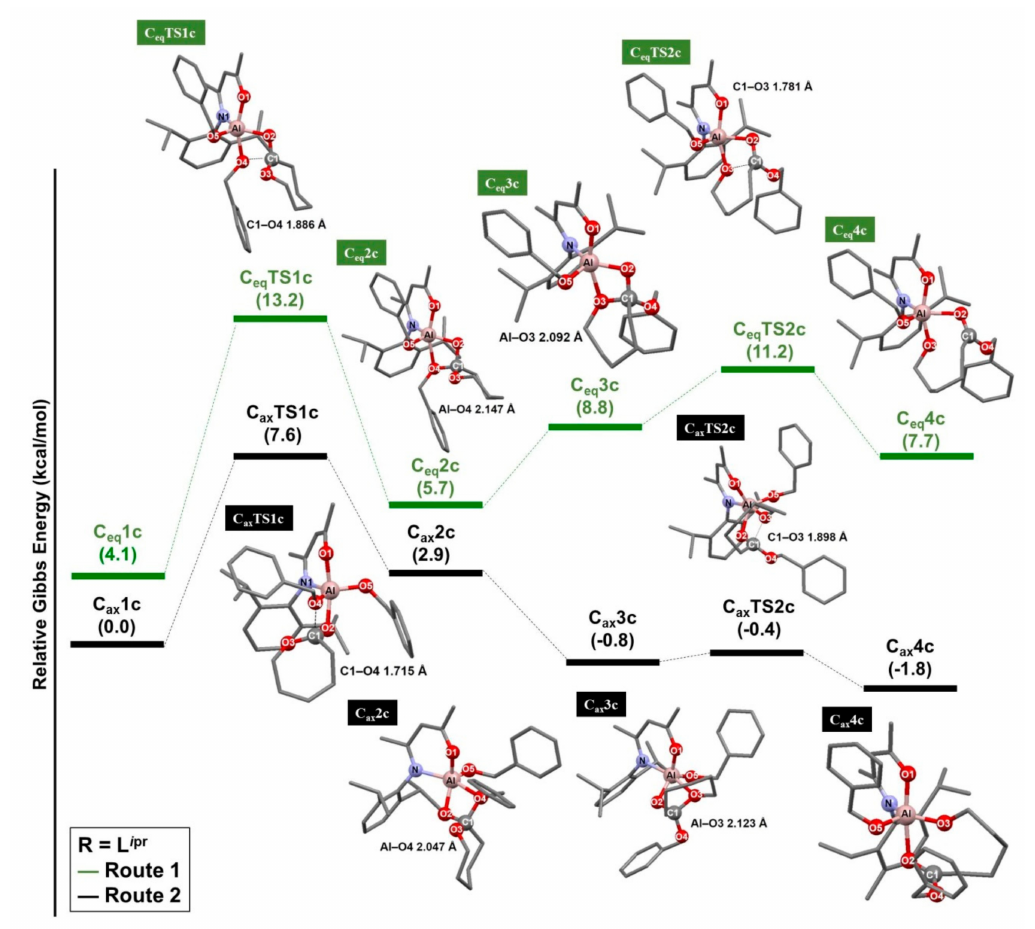
Figure 7. Reaction profile and optimized structures of the L i Pr system. (Monomer: ε